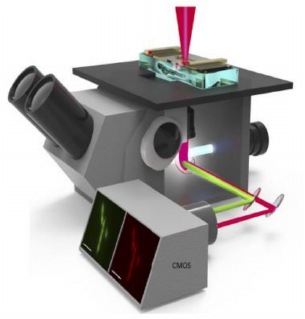
Figure 44. Temperature jump fluorescence Imaging microscope